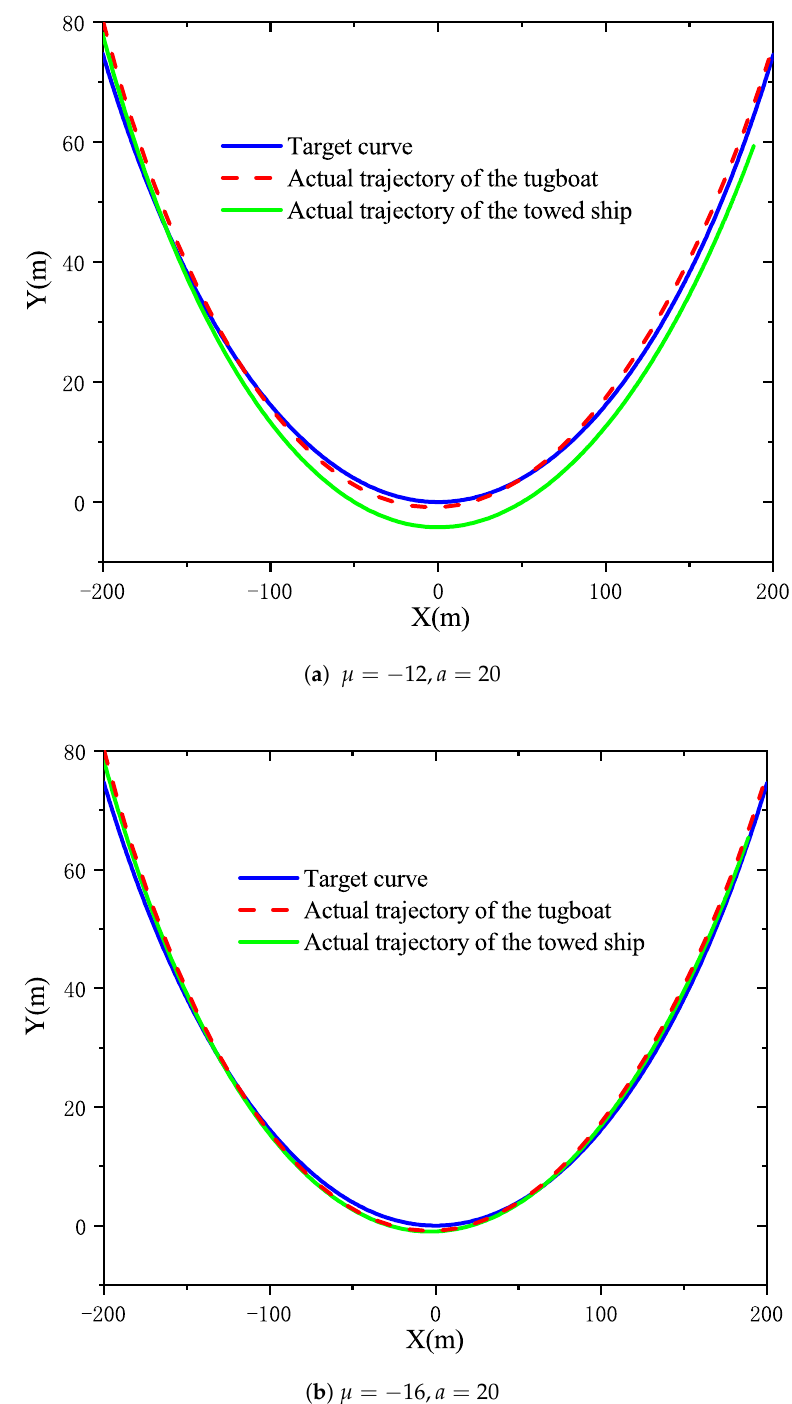
Figure 5. Comparison of actual motion trajectories of the towed ship between different steering